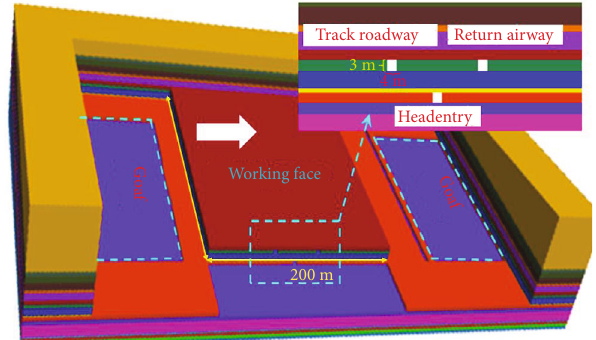
Figure 8: Numerical model of crossing the abandoned